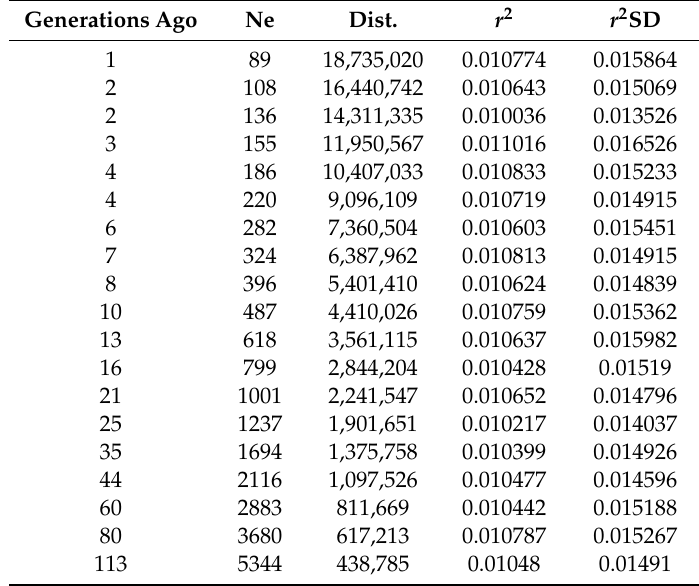
Table 4. E ff ective population size in dromedary camel across 113 last generations. Generations Ago Ne